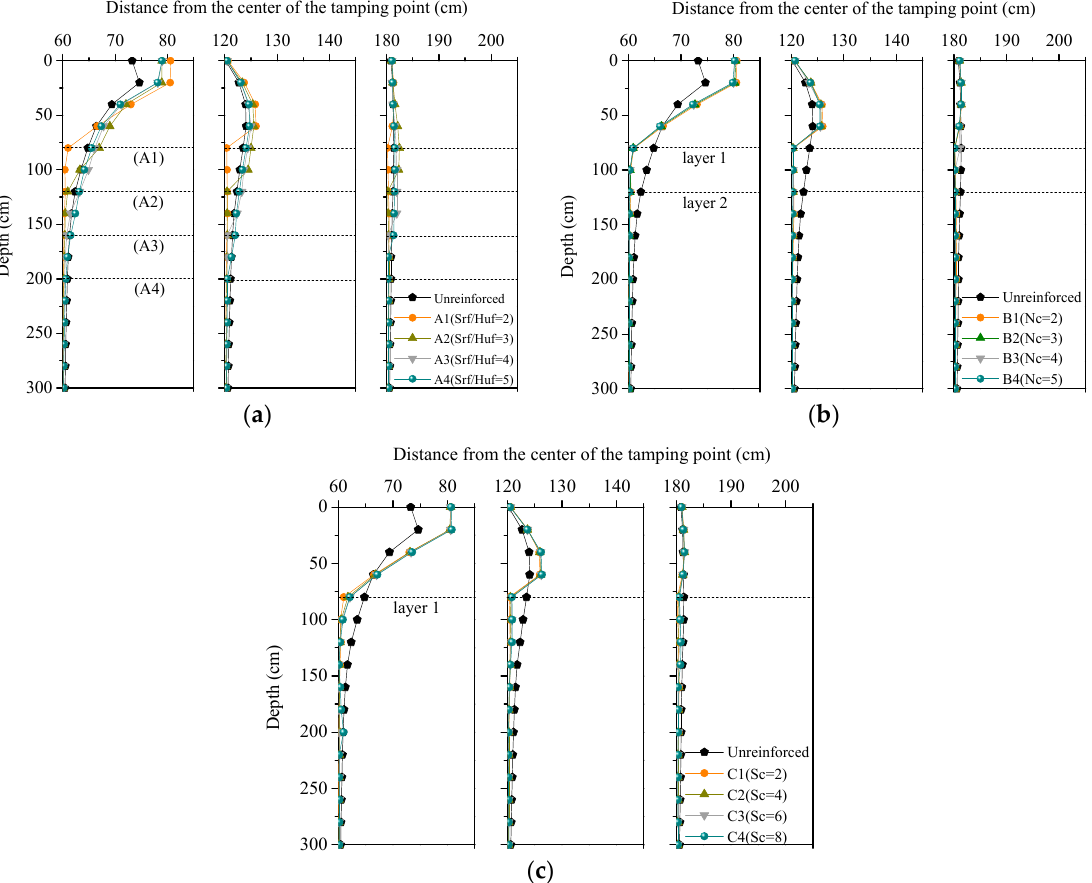
Figure 4. The vertical displacement under three factors: ( a ) embedded ratio; ( b ) number of reinforced layers; ( c ) interval of reinforced layers.